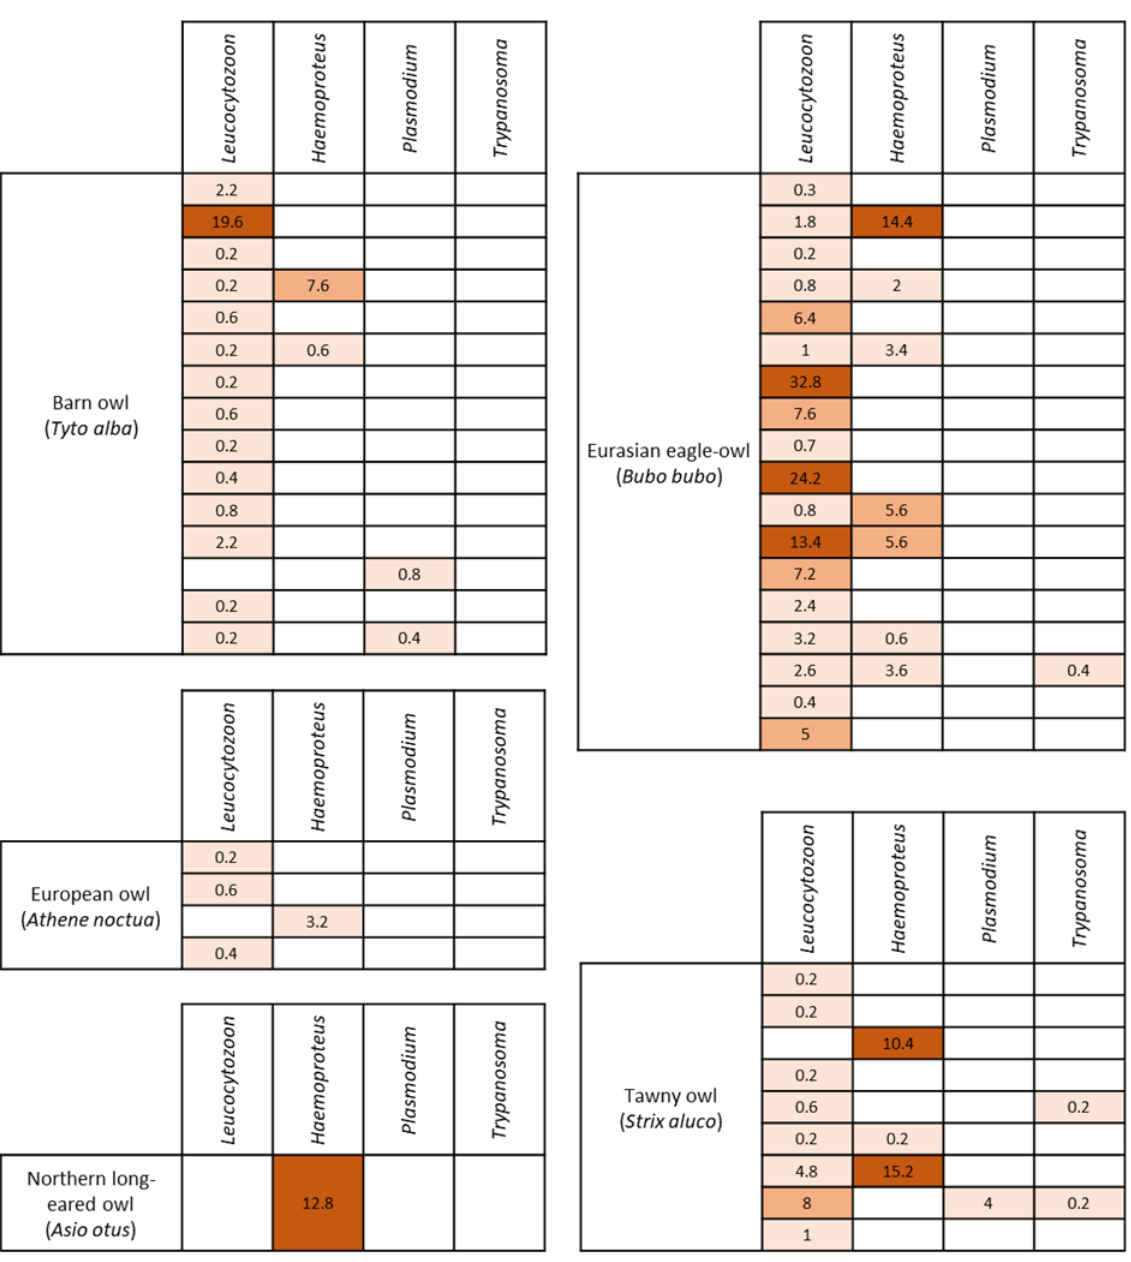
Figure 2. Detection of the four different genera of hemoparasites according to bird species and heat map of parasitemia (expressed in parasites per 1000 RBC).Finally, coinfection was observed in